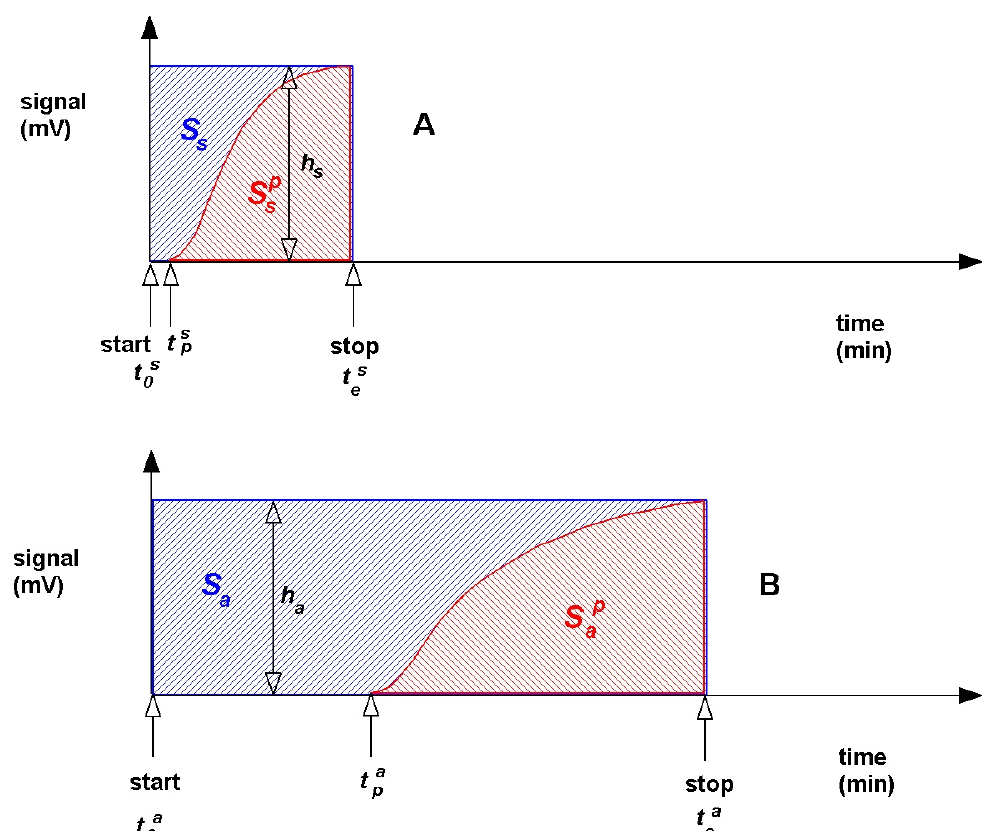
Figure 2. The concentration of adsorbate versus time in the outlet on the chromatographic column: ( A ) reference column and ( B ) adsorbent column.